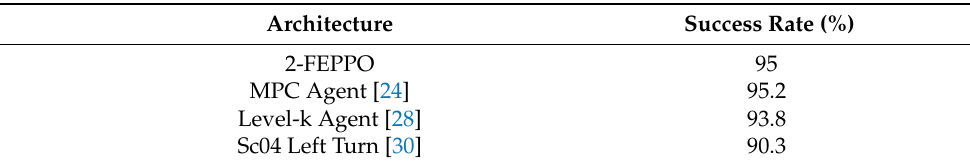
Table 4. Comparison of success rate between different